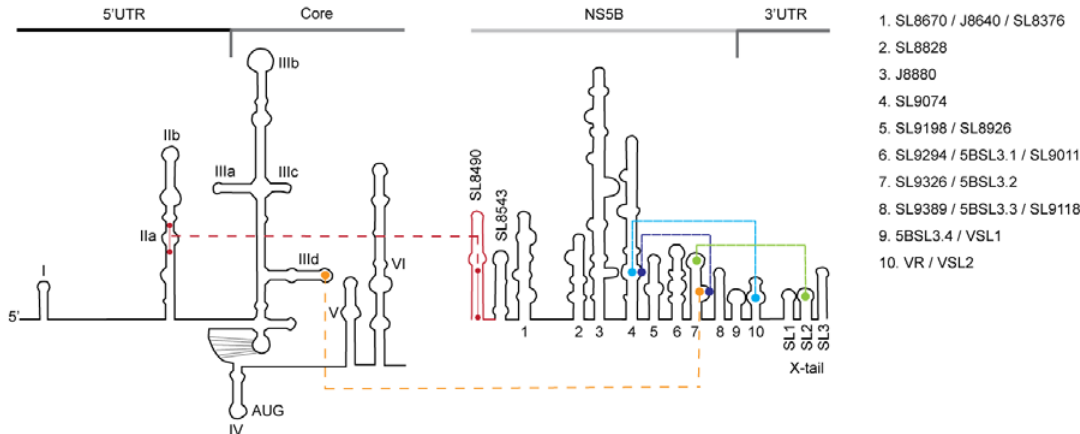
Figure 6. Secondary structural elements located in the 5’UTR-Core and the NS5B-3’UTR. Tertiary interactions between 5’UTR IIa nt 95–110 and NS5B SL8490 nt 8528–8543 are indicated by the red line. Tertiary interactions of SL9326 with the 3’UTR X-tail SL2 are indicated by the green line. SL9326 interaction with NS5B SL9074 and the 3’UTR Variable Region (VR, VSL2) is indicated by the blue and turquoise lines, respectively. SL9326 interaction with the IRES IIId apical loop is indicated by the yellow line. Listed NS5B-3’UTR stem-loop nomenclature is based on Adams RL et al. 2017, Figure 1 [15].